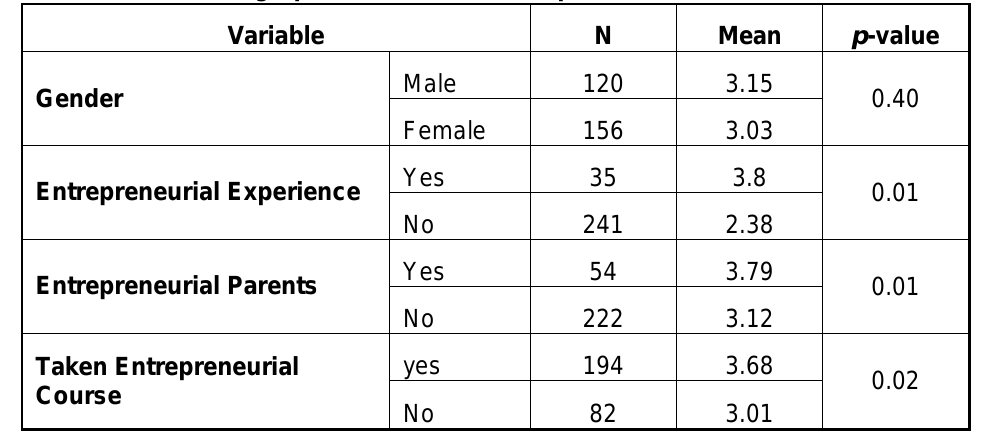
Table-2 Impact of Self-Efficacy and Locus of Control on Entrepreneurial Intentions Self